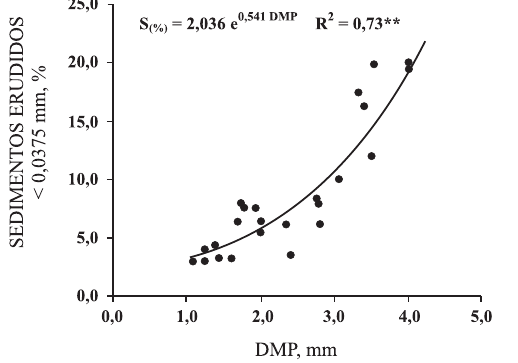
Figura 6. Relação do percentual (base de massa) dos sedimentos erodidos com tamanho < 0,0375 mm, avaliado na condição de equilíbrio enxurrada, com o diâmetro médio ponderado (DMP) dos agregados do